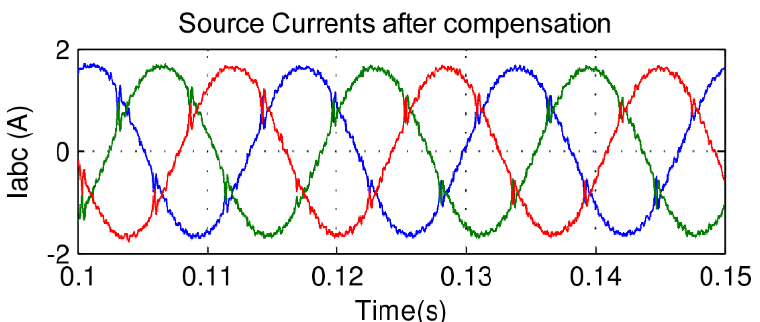
Figure 16. Source current with three-phase induction motor.